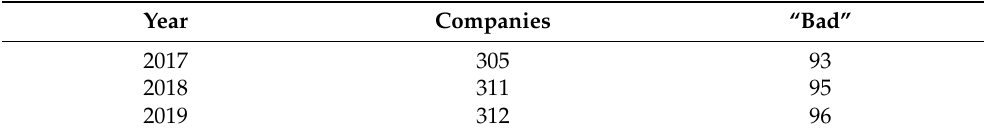
Table 8. Number of observations and companies classified as “bad” by year.